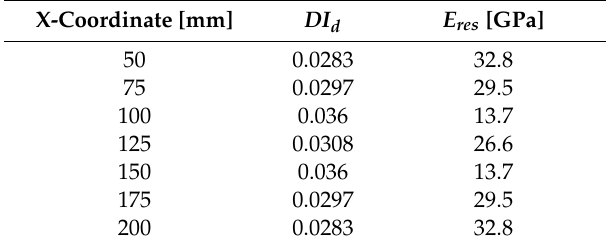
Table 2. Residual Young’s moduli and corresponding DI d values at specific